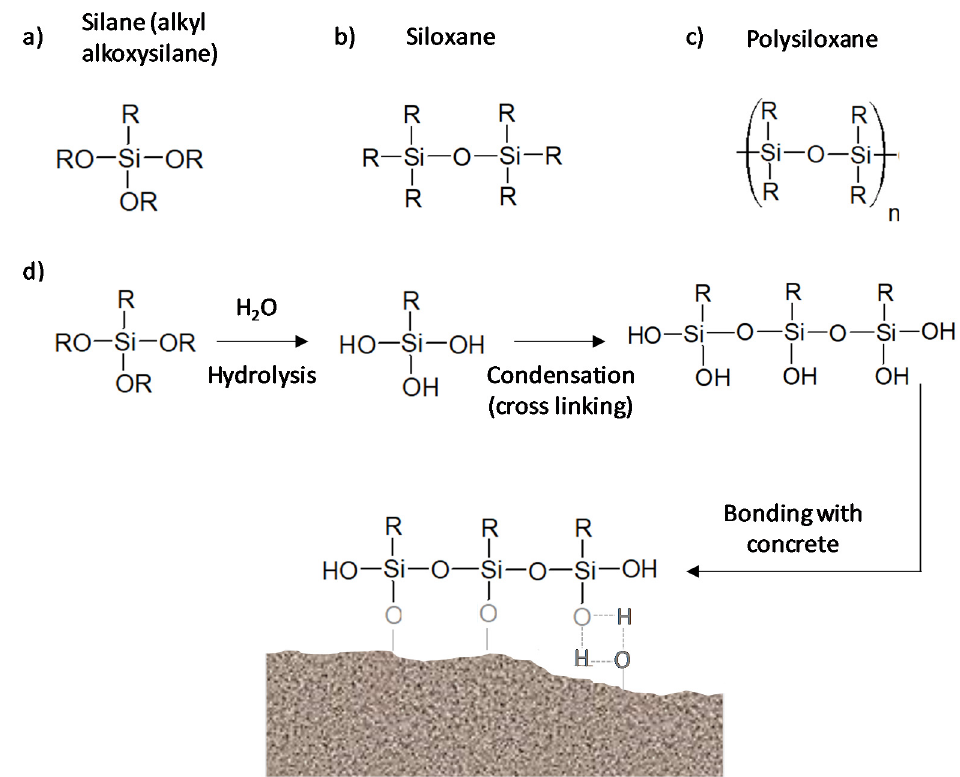
Figure 8. Chemical reactions between silane and cementitious substrate (-R = C n H 2n+1 , alkyl groups). ( a ) Structure of an alkyl alkoxysilane (silane for simplicity); ( b ) structure of a siloxane and ( c ) of a polysiloxane; ( d ) schematised reactions path from a silane molecule to polysiloxane bonded to concrete. These compounds are applied as water emulsion or gel-type or cream-type mixed with